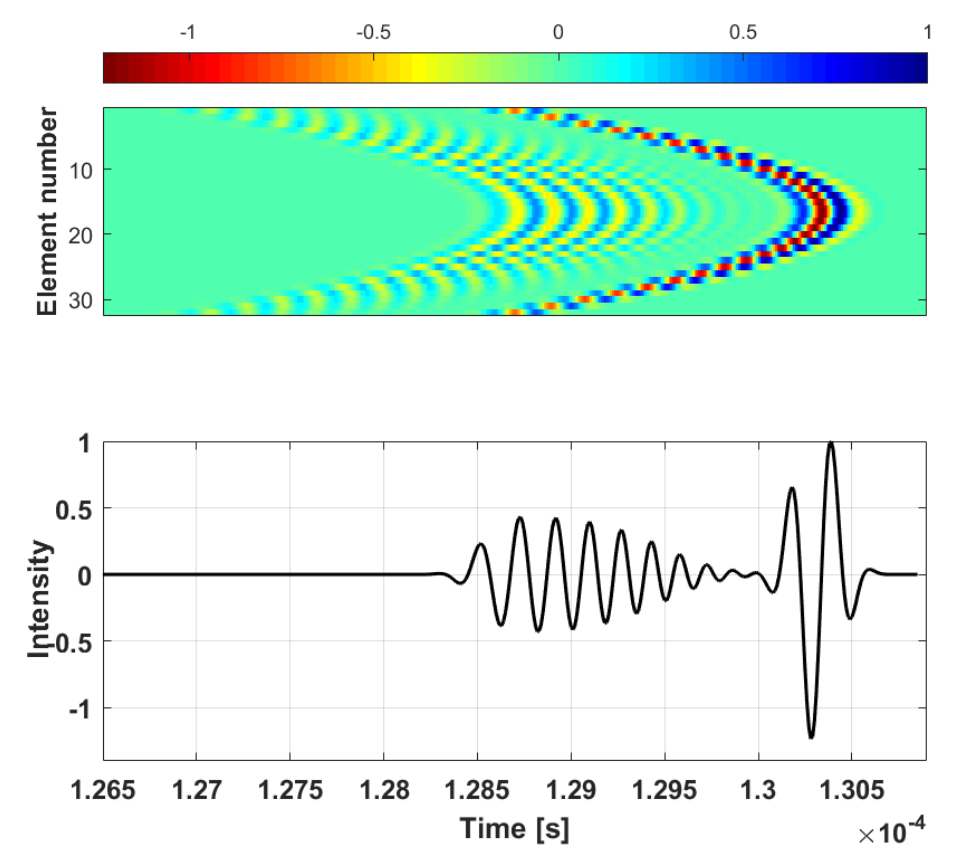
Figure 7. Received intensities from the individual elements of a linear array transducer ( top ) and the individual response of center element ( bottom